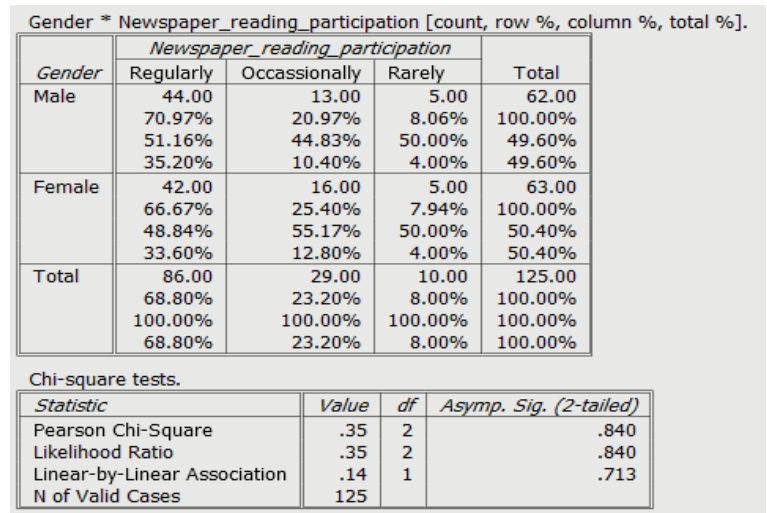
Figure 1: Cross Tabulation and Chi-square between Gender v/s Newspaper Reading Participation (Source: Authors‟ depiction)